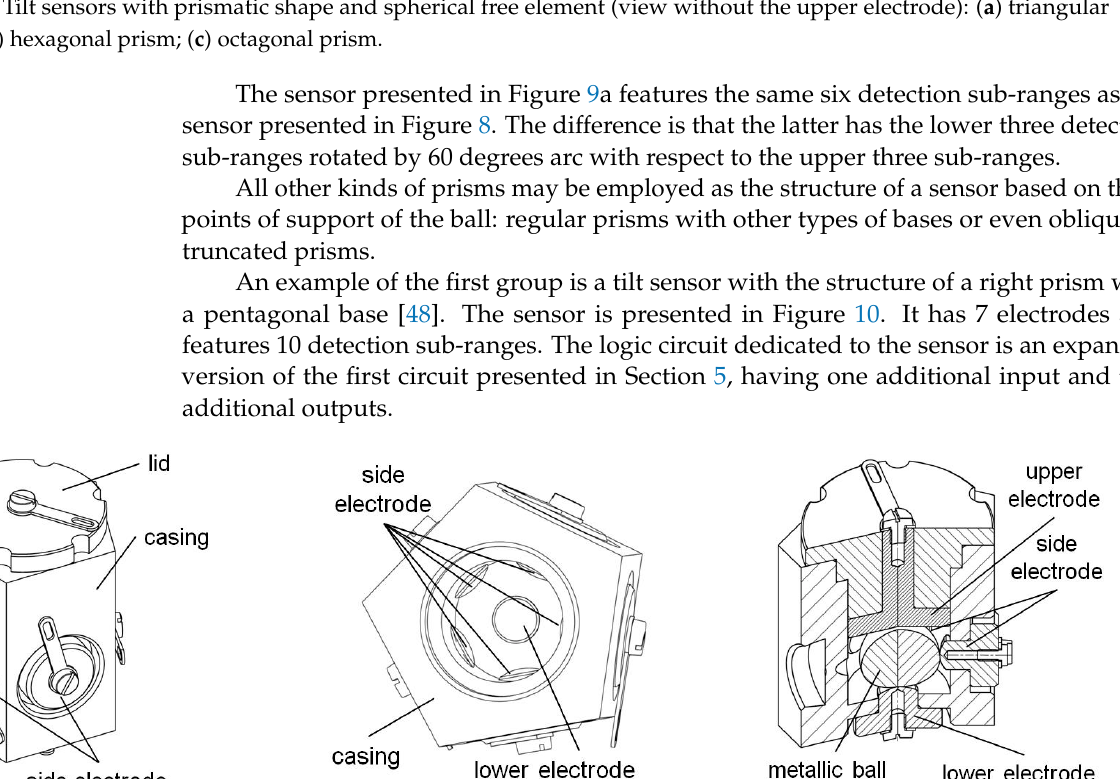
Figure 9. Tilt sensors with prismatic shape and spherical free element (view without the upper electrode): ( a ) triangular prism; ( b ) hexagonal prism; ( c ) octagonal prism.